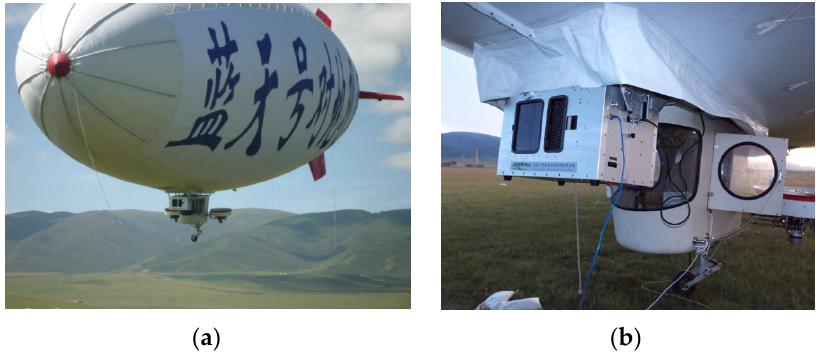
Figure 1. ( a ) “LanTianHao” HAA navigated at an altitude above 4100 m with a payload greater than 200 kg; and ( b ) docking of “LanTianHao” HAA and “LanTianHao” EOPS.